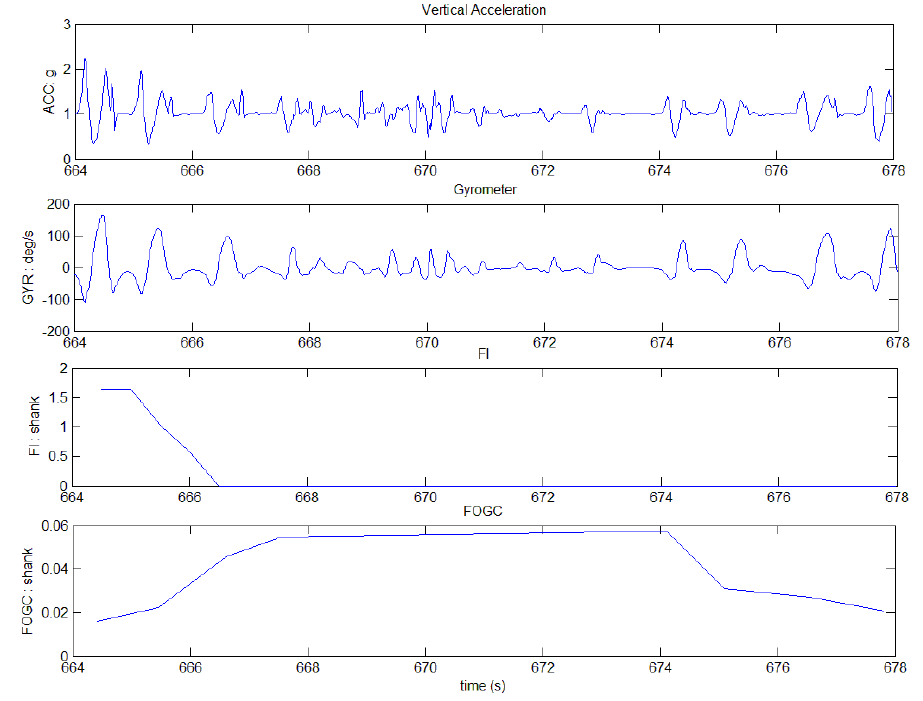
Figure 5. IMU rough data corresponding Figure 4 non-detected FOG